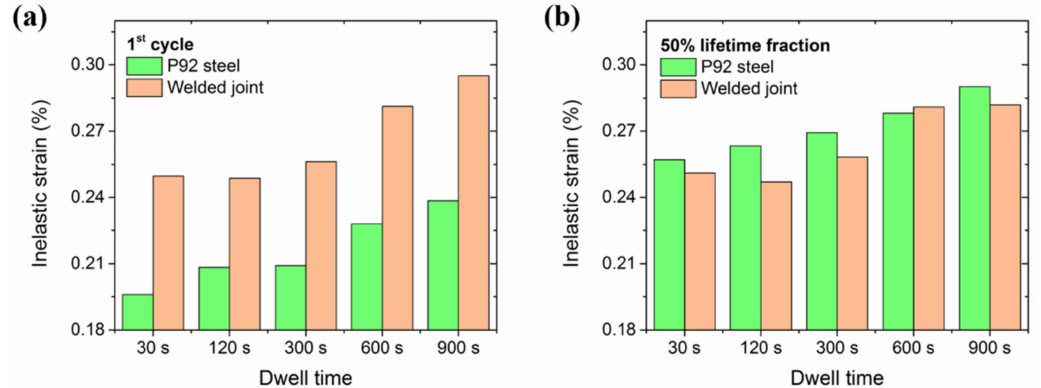
Figure 7. Variations in measured inelastic strain for welded and BM specimens with different holding times at ( a ) the 1st cycle and ( b ) 50% of the lifetime